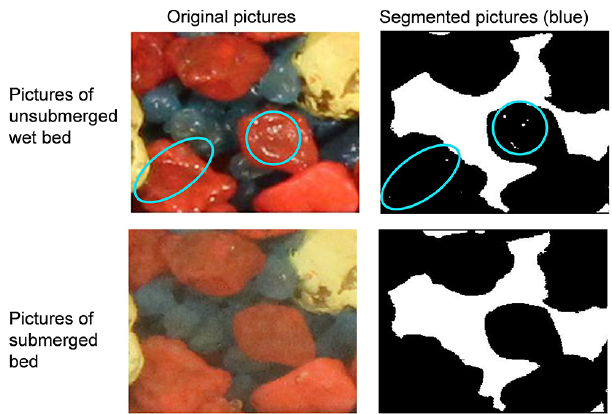
Figure 10. Example of the e ff ect of water depth on the areal frac- tion in patch 5. The data represent the areal fraction of the three size fractions for di ff erent water depths obtained through processing of images covering the same surface area.